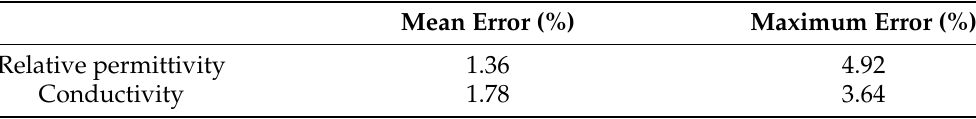
Table 1. The mean and the maximum value of the validation error across all frequency points, in percentage. The mean error is the mean across all validation measurements ( n = 99). The maximum error is the maximum across all validation